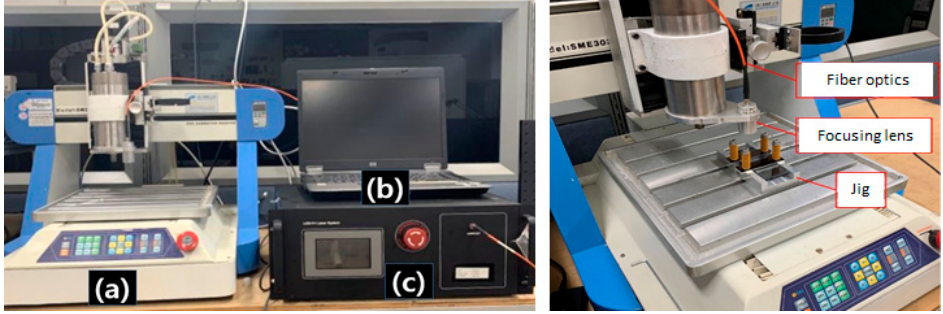
Figure 1. Experimental setup.